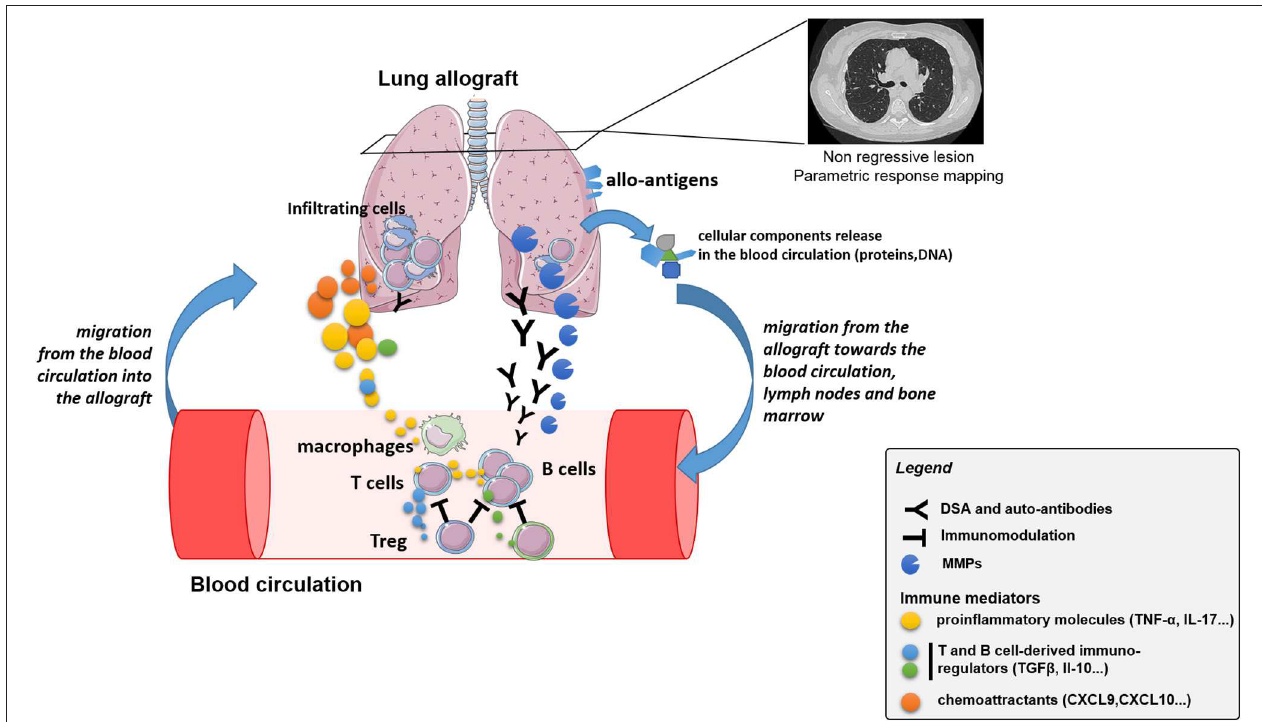
FIGURE 2 | Schematic representation of the crosstalk between immune cells and allograft, with associated potential biomarkers, leading to